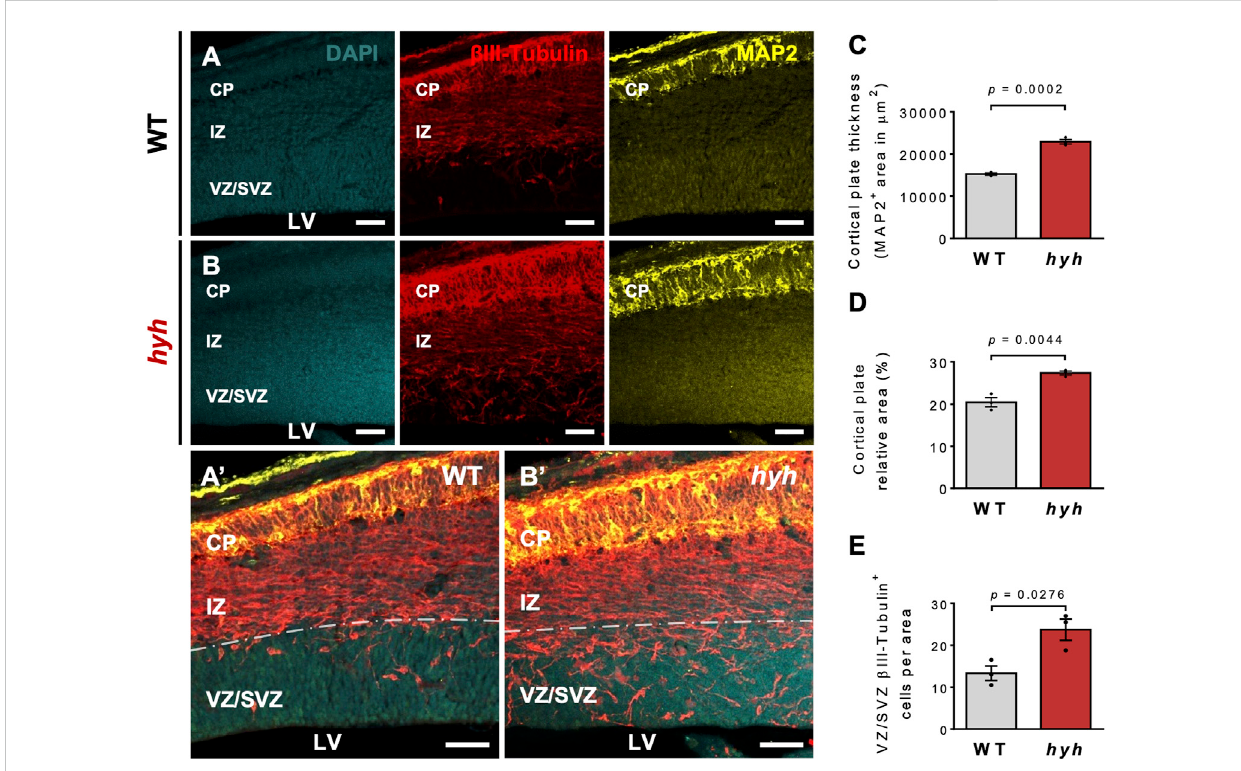
FIGURE 3 Increased neuronal differentiation in hyh embryonic brains. (A,B) . Representative coronal sections of WT (A) and hyh mutants (B) at E14.5 immunostained for β III-tubulin (red) and MAP2 (yellow). Cell nuclei were stained with DAPI (blue). β III-tubulin + cells are committed with the neuronal lineage and MAP2+ cells are maturing neurons. Ventricular zone/Subventricular zone (VZ/SVZ), intermediate zone (IZ), and cortical plate (CP) are depicted. Note that maturing neurons are mainly located in the CP. (A ’ ,B ’ ) . Higher magni fi cations of the merged images showed in A and B, respectively. Dashed line indicates the limit between SVZ and IZ. (C) . Morphometric analysis of CP (MAP2+ cells) thickness in WT (n = 3) and hyh (n = 3) mice. (D) . Morphometric analysis of CP relative area (CP area/pallium area) in WT (n = 3) and hyh (n = 3) mice. (E) . Quanti fi cation of β III-tubulin + cells in the VZ/SVZ normalized by sampled area in WT (n = 3) and hyh (n = 3) mice. Data is shown as mean +/- S.E.M. Differences with p < 0.05 were considered signi fi cant (Student ’ s t-test with Welch ’ s correction). LV: Lateral Ventricles. Scale Bars: A-B = 50 µm; A ’ -B ’ = 50